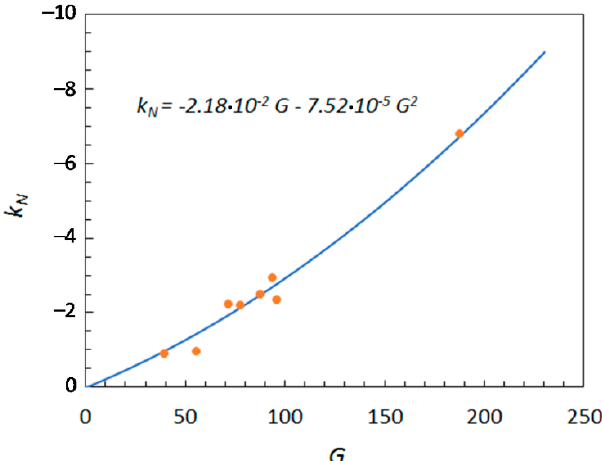
Figure 4. Effect of the global information index ( G ) on the Norrish constant ( k N, ), according to the second-order polynomial model (Equation (10)). Data points represent the experimental Norrish constant values.